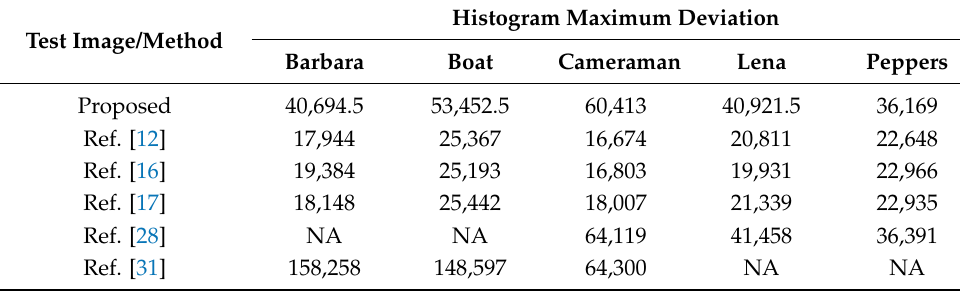
Table 5. Histogram Maximum Deviation. Test